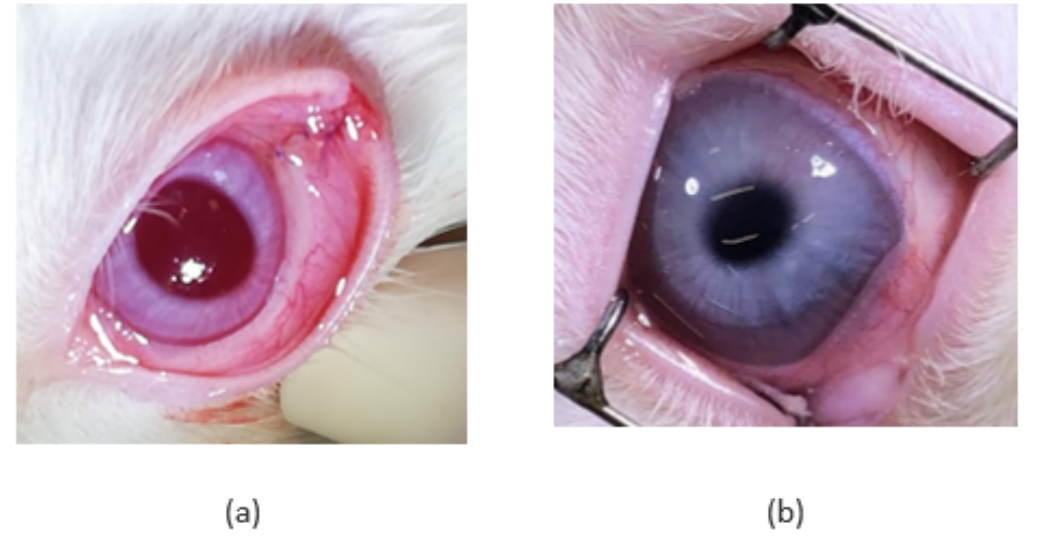
Figure 2. The appearance of the eye in the non-cryo group: ( a ) immediately after the implant administration and ( b ) 2 weeks later, after the implant removal. Table 1. Clinical grading of findings observed 7 days after implantation.